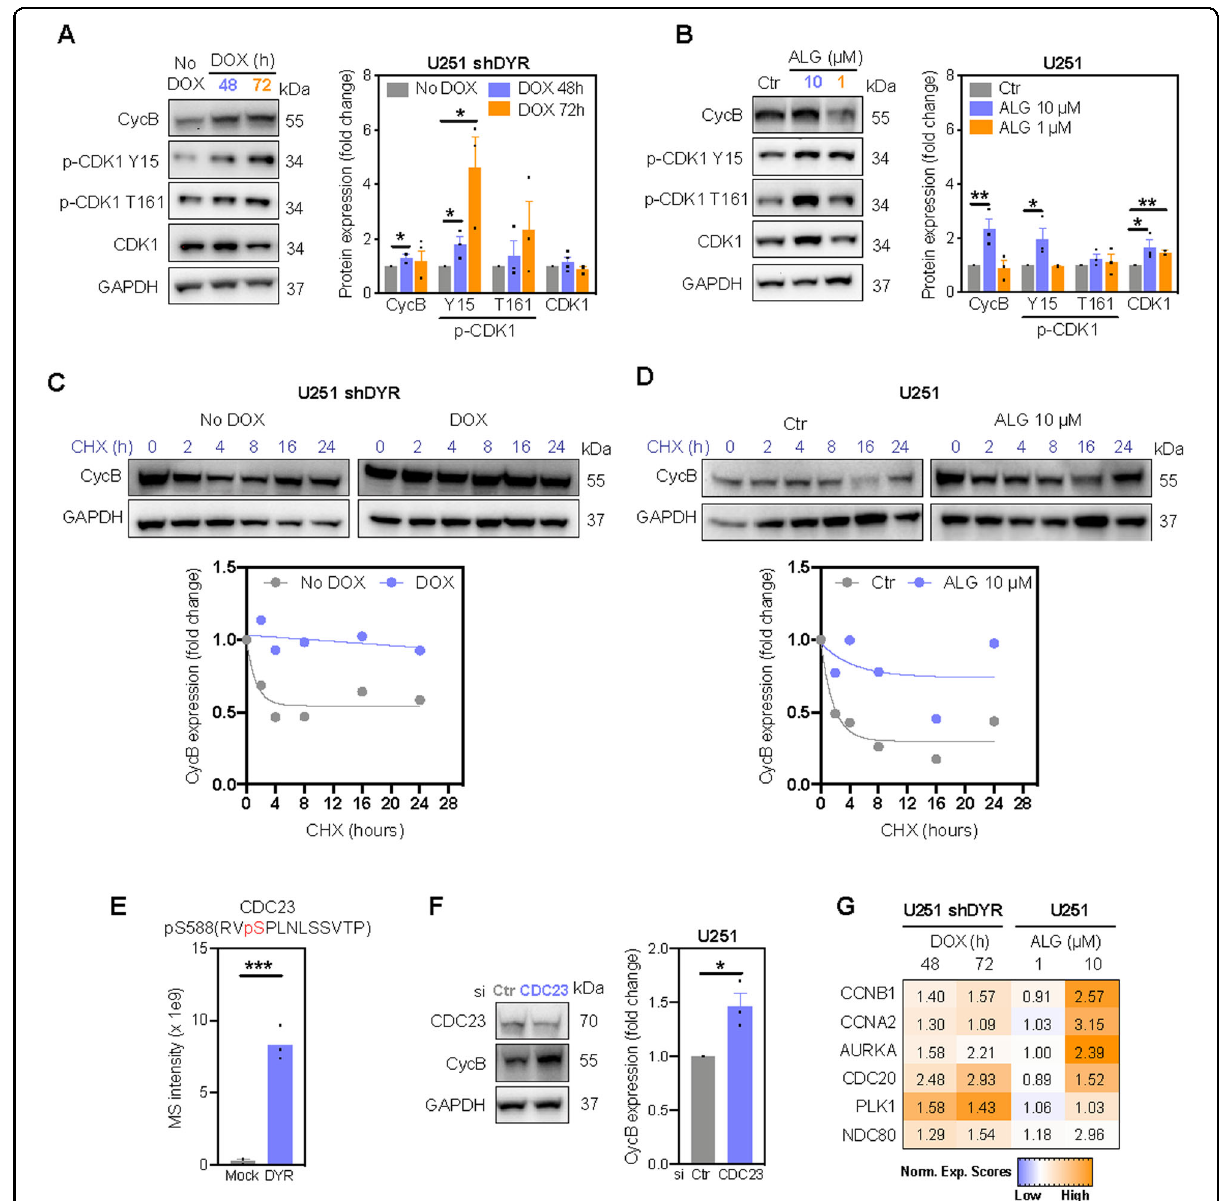
Fig. 3 DYRK1A inhibition prevents cyclin B degradation. Immunoblot analysis and densitometric quanti fi cation of cyclin B (CycB), phosphorylated (p-CDK1) and total CDK1 in ( A ) U251 shDYR cells treated ± DOX and ( B ) U251 cells treated ± DYRK1A inhibitor ALGERNON (ALG, 72 h). Degradation of cyclin B (CycB) in U251 shDYR cells treated ± DOX ( C ) and U251 cells treated ± ALG ( D ). Cells were treated with DOX or ALG for 72 h before cycloheximide (CHX) treatment. Representative images and quanti fi cation from two independent experiments are shown. E Mass spectrometry (MS) intensity of CDC23 phosphorylated at S588 by DYRK1A in vitro. F Immunoblot analysis and densitometric quanti fi cation of cyclin B expression in cells transfected with siRNA targeting CDC23 (72 h). G Heatmap of protein levels of anaphase-promoting complex substrates cyclin B1 (CCNB1), cyclin A2 (CCNA2), Aurora kinase A (AURKA), cell-division cycle protein 20 (CDC20), Polo-like kinase 1 (PLK1) and kinetochore protein NDC80 in U251 cells following doxycycline-induced DYRK1A knockdown (DOX) and inhibition with ALG (72 h). Data represent fold change of replicates to their respective controls. All bar graphs represent mean ± SEM of at least three independent experiments (two-tailed unpaired t -test; * P < 0.05, ** P < 0.01, *** P <